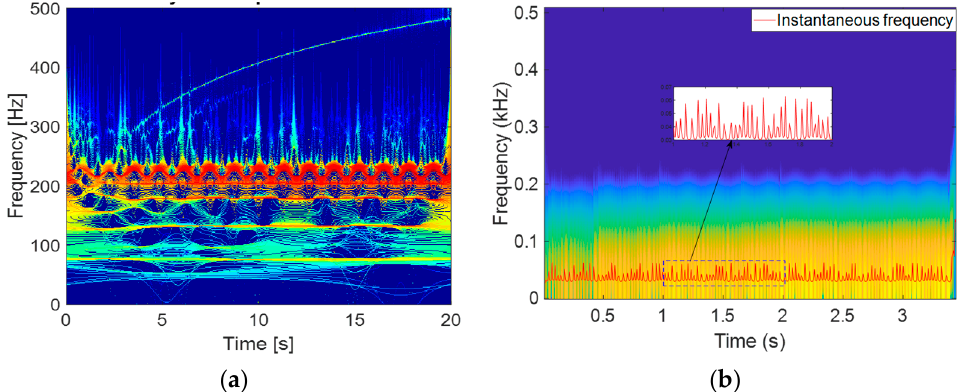
( b ) Figure 10. Time–frequency map of rotor-stator contact; ( a ) WSST response; ( b ) IF response. The study shows that when fl uid is introduced into the system, the WSST response